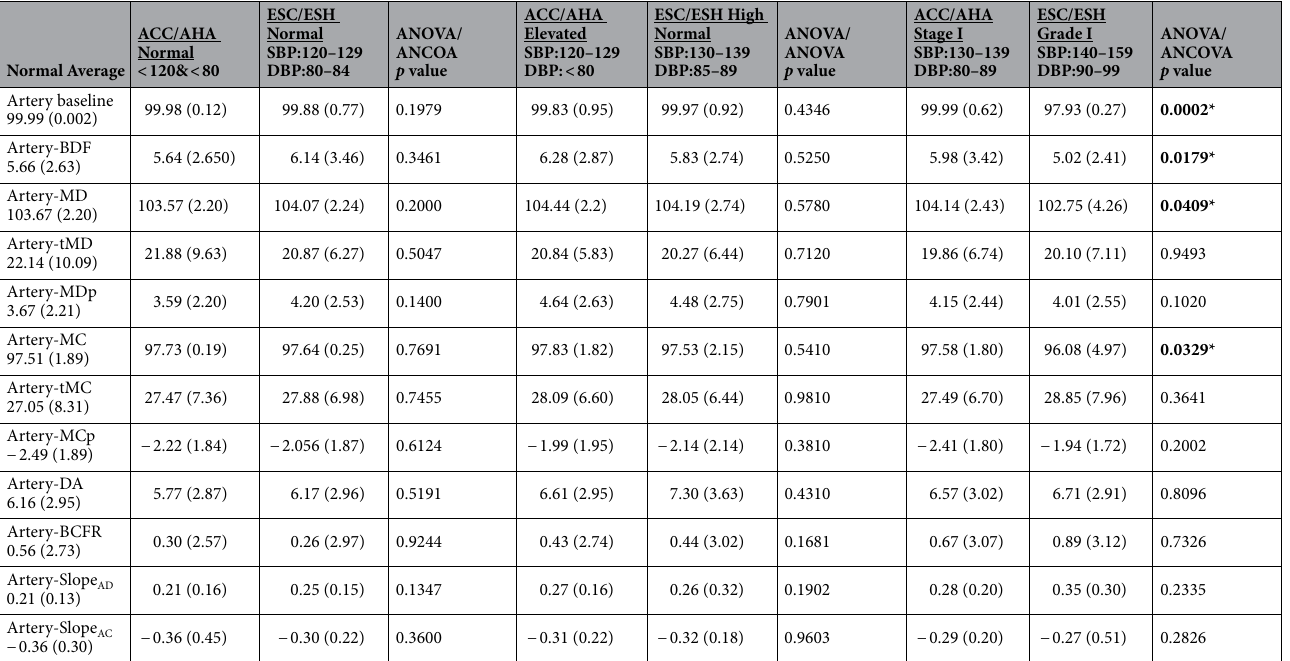
Table 2. Summary of retinal arterial vascular function parameters. Abbreviations: ANOVA, analysis of variance; ANCOVA, analysis of covariance; Baseline, baseline diameter; BDF, baseline diameter